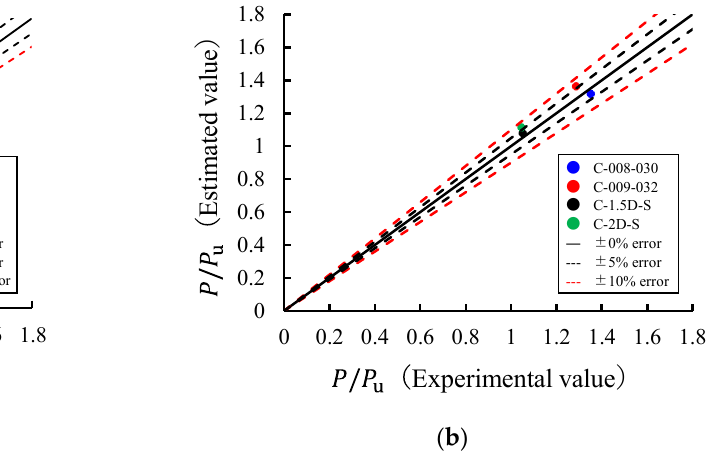
Figure 16. Comparison of experimental to estimated values: ( a ) Buckling position not considered; ( b ) Buckling position considered.